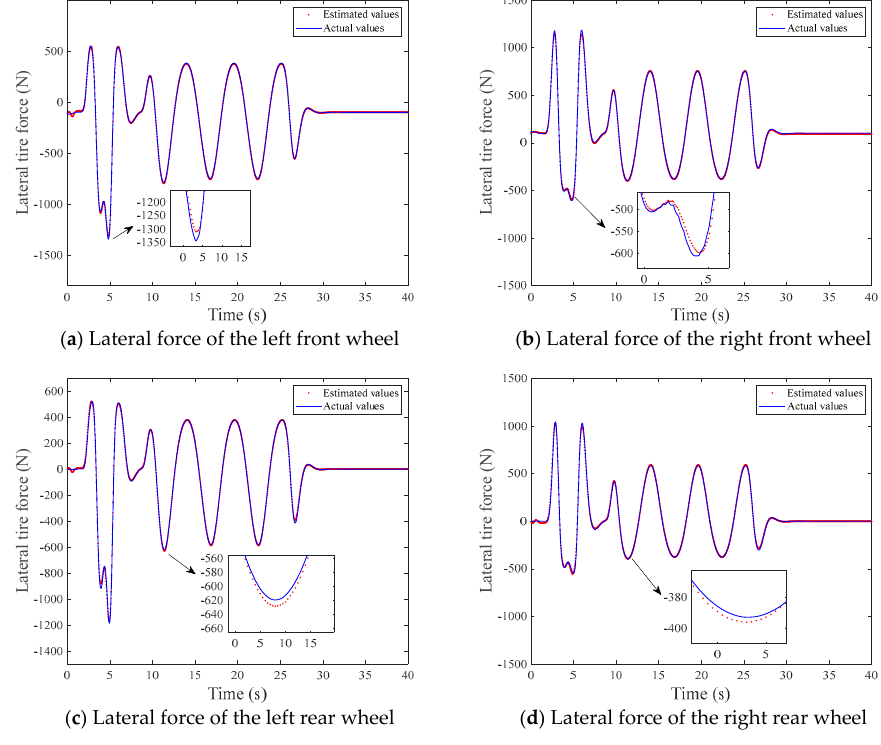
Figure 13. The lateral tire force of the wheels.